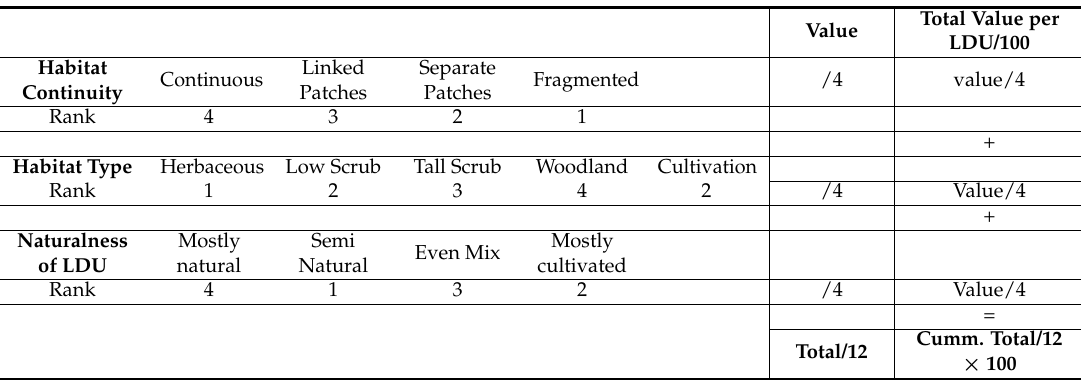
Table 4. Ecological Integrity ranking method.